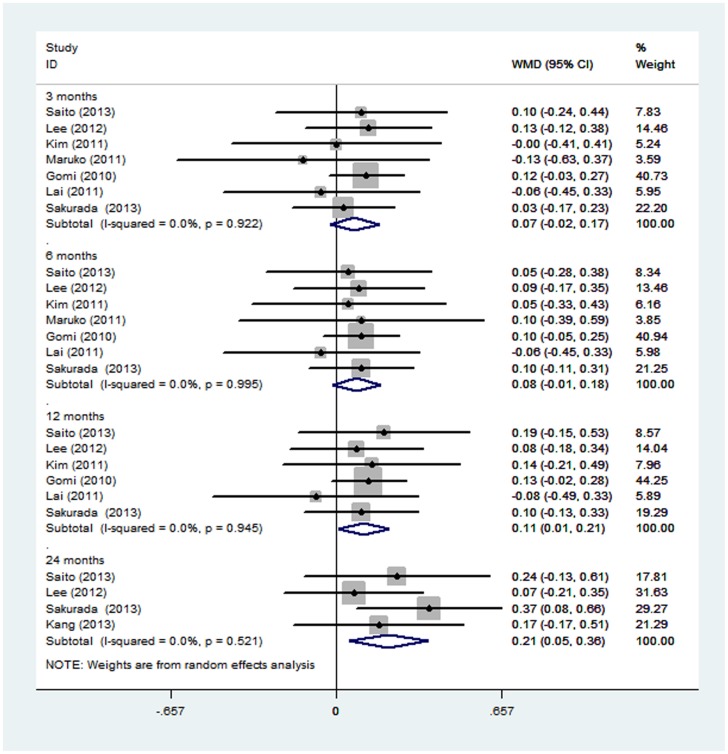
Forest plot displaying the pooled summary estimates of visual acuity in the combined PDT and anti-VEGF therapy group versus the PDT monotherapy group.VA = visual acuity.